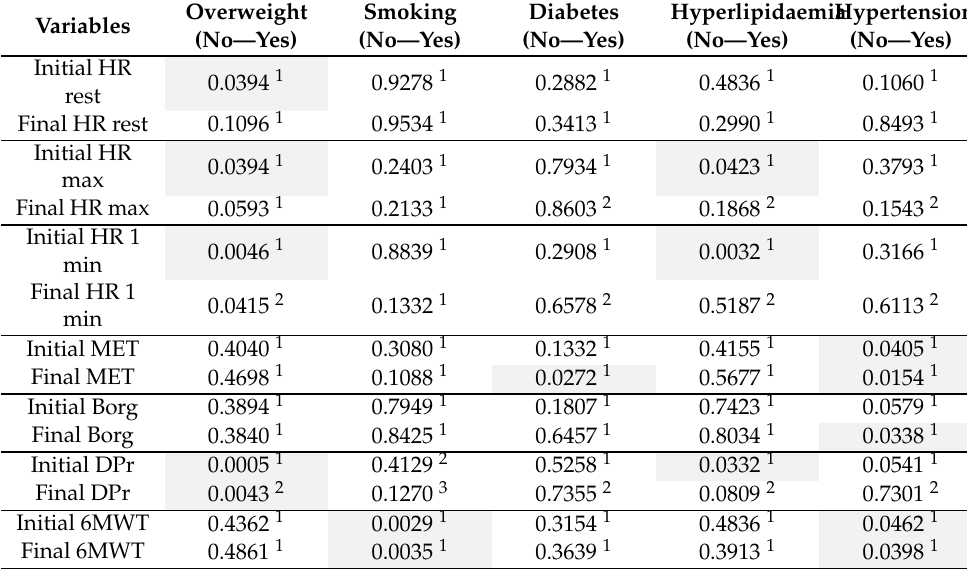
Table 5. The p -value parameters HR rest, HR max, HR 1 min, MET, DPr, and 6MWT between the examination before and after cardiac